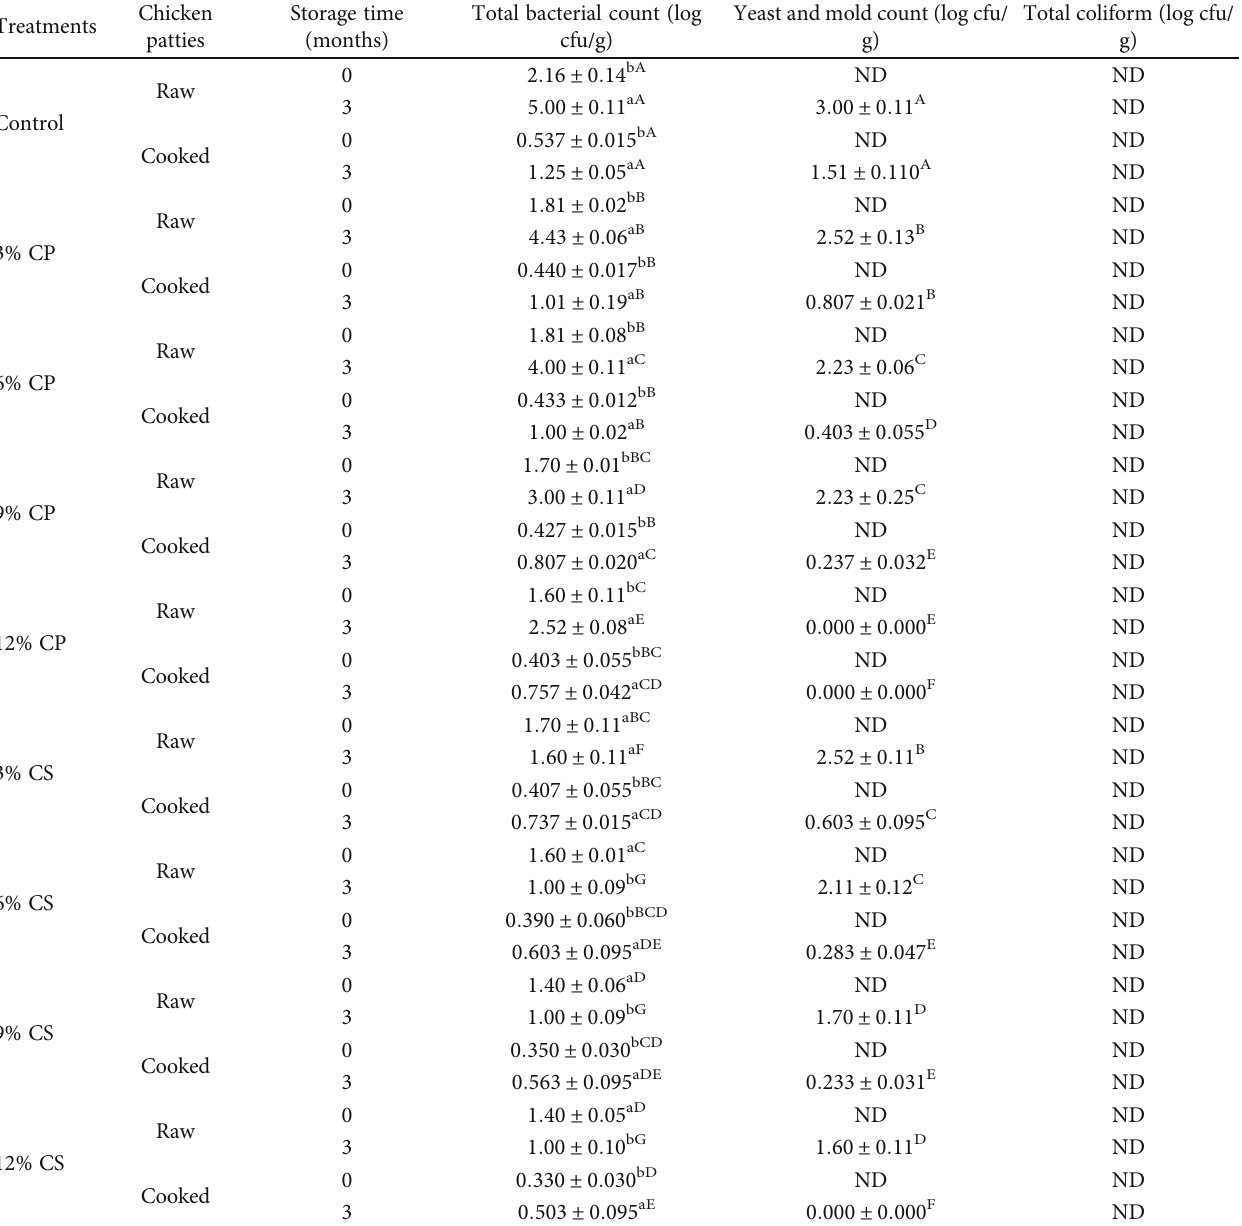
Table 6: Changes in microbiological quality of raw and cooked chicken patties supplemented with cantaloupe peel (CP) and seeds (CS) powder during storage at -20 for 3